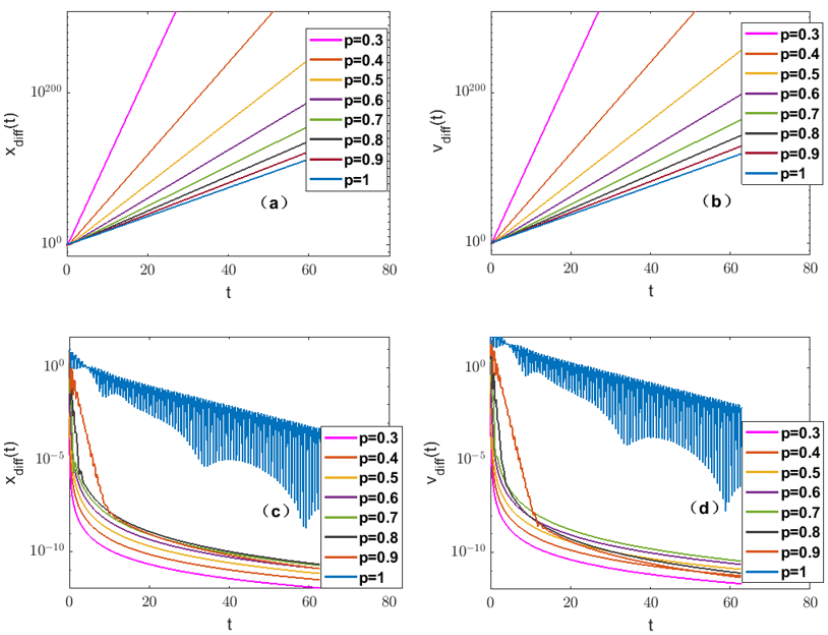
Figure 3. Average position difference function x dif f ( t ) ( a , c ) and average velocity difference function v dif f ( t ) ( b , d ) curves of time of the fractional-order multi-agent system (3) with different orders p when a = 1 ( a , b ) and a = 20 ( c , d ) (the case d ≥ 0, c < 0 ). Under the same simulation conditions as Figure 3, Figure 4 plots the time-varying curves of the position and velocity of each agent as a function of time when the order is 𝑝 = 0.8 , where the potential field parameter in Figure 4a,b is 𝑎 = 1 , and in Figure 4c,d is